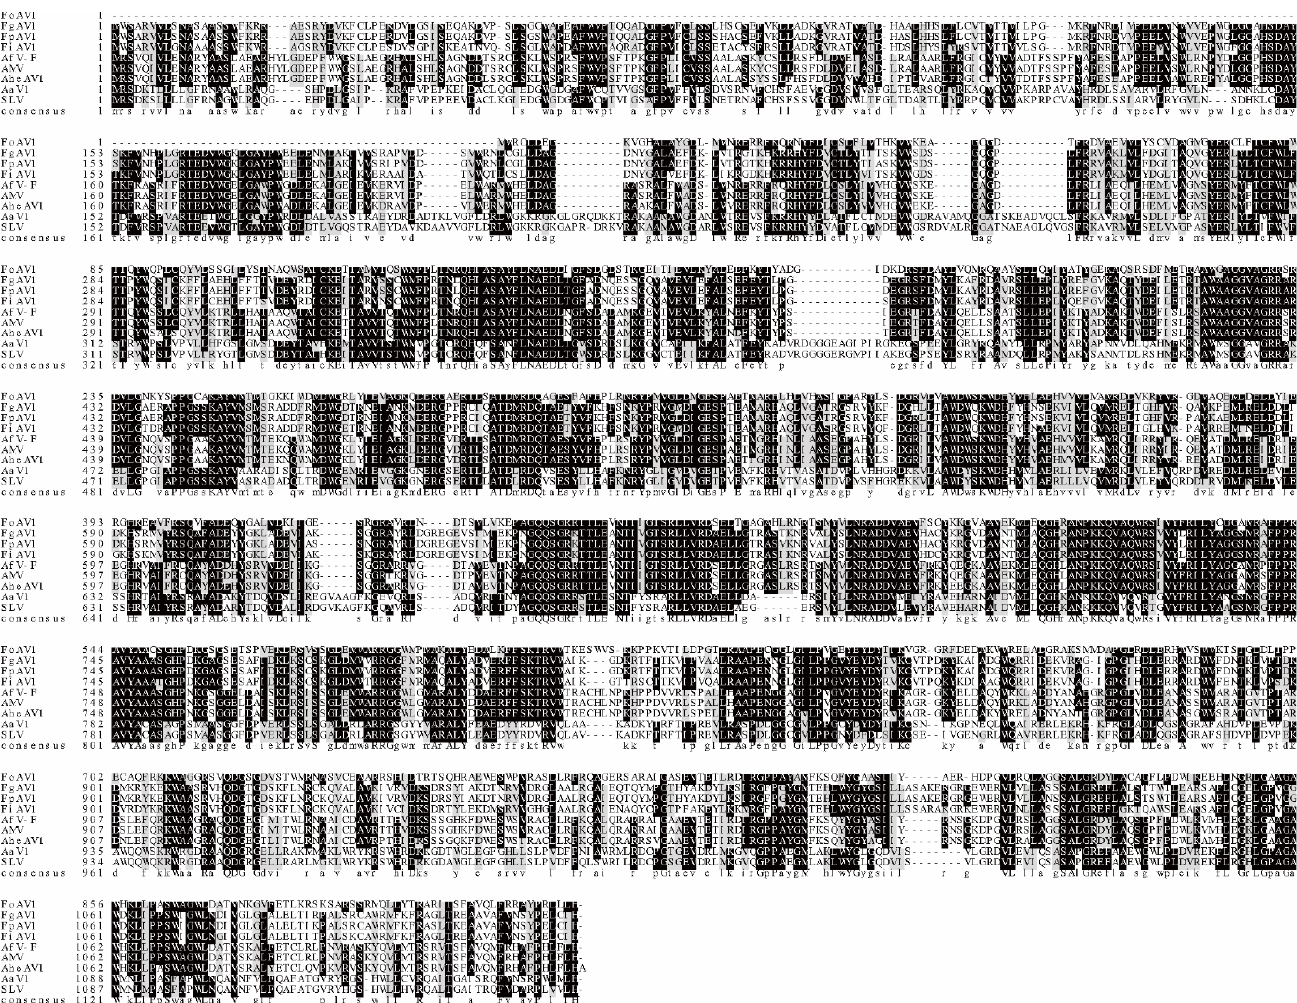
Figure 3. Multiple alignment of the conserved RdRp amino acid motifs encoded by FoAV1 and other “Alternaviridae” family members.